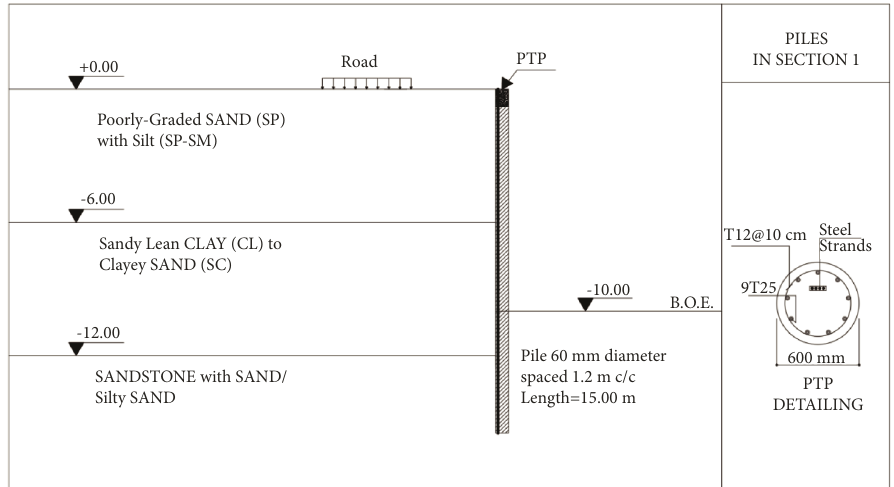
Figure 2: Shoring section 1.